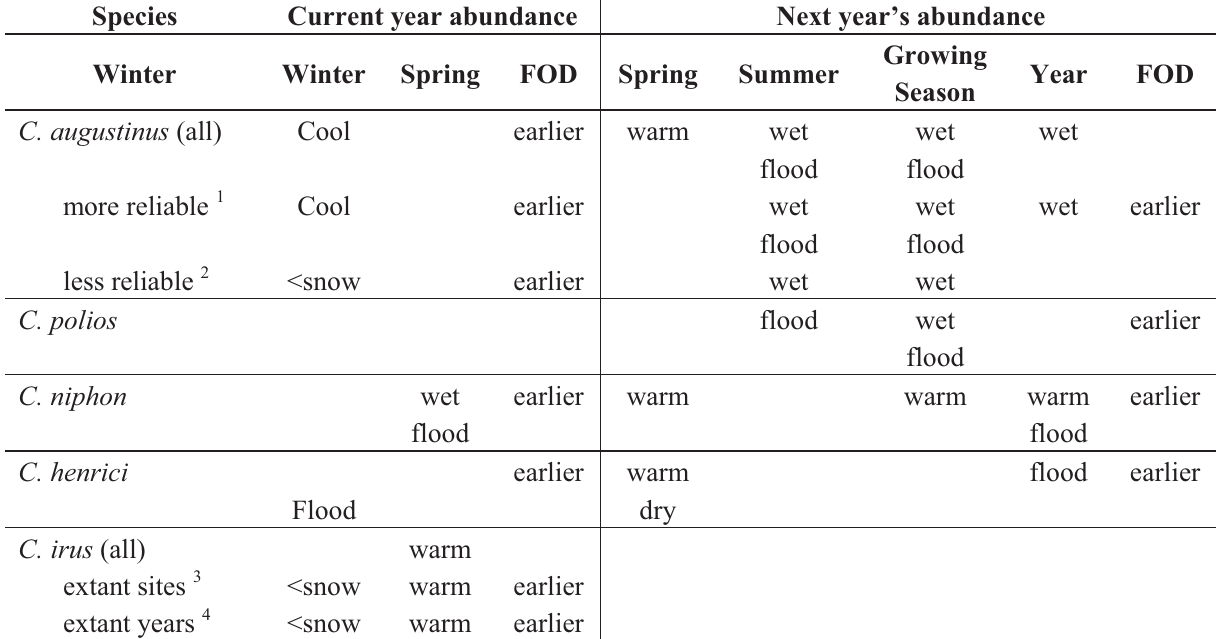
Table 11. Results of Spearman rank correlations of abundance of each study species each year in each study site with climate factors and first observed date (FOD) (Table 9) of that species, by species. The conditions significantly correlated with higher abundance are described. “ Flood ” = significantly correlated with soil moisture at the high end of the spectrum on the Palmer Index (see Methods). See Appendix Table A1 for numerical test results.